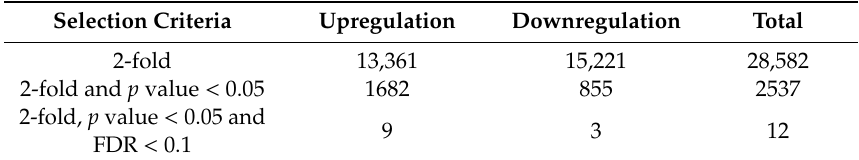
ethylene-treated ‘Haegeum’ gold kiwifruit.